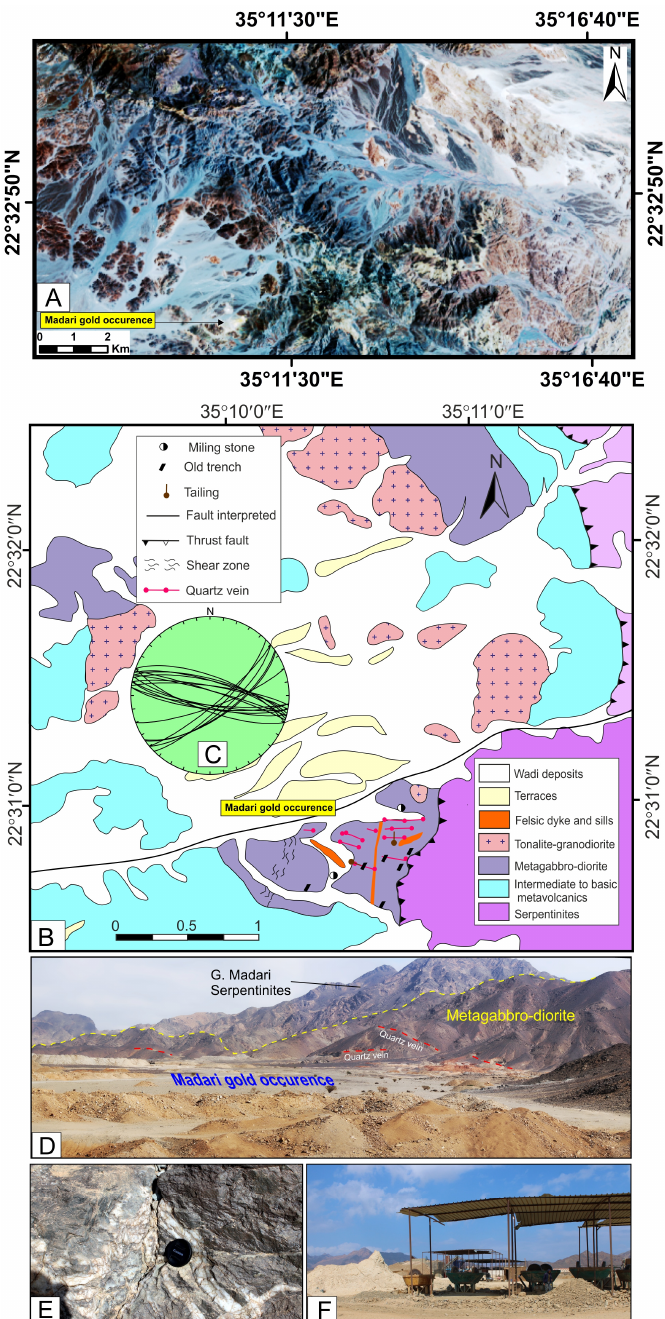
Figure 17. ( A ) Location of the Madari gold occurrence on Landsat-8 OLI band composites RGB-753, ( B ) Geologic map of the Madari area (modified after [88]), ( C ) The black lines are the great circle plots of the quartz veins in Madari gold occurrence, ( D ) The recent gold-mining works in Madari occurrence are limited to brecciated, smokey and high-grade quartz veins that are enclosed in metagabbro, ( E ) Quartz folded to asymmetric isoclinal fold in metagabbro of Madari occurrence, ( F ) Milling stones and gold-mining works in Madari